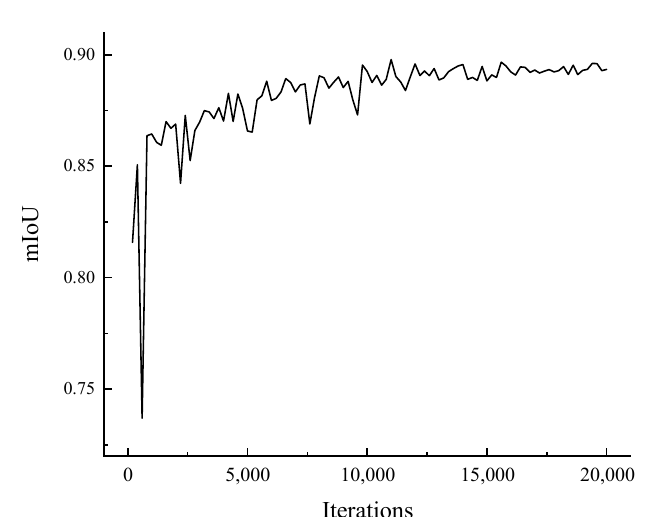
Figure 11. Loss curve.